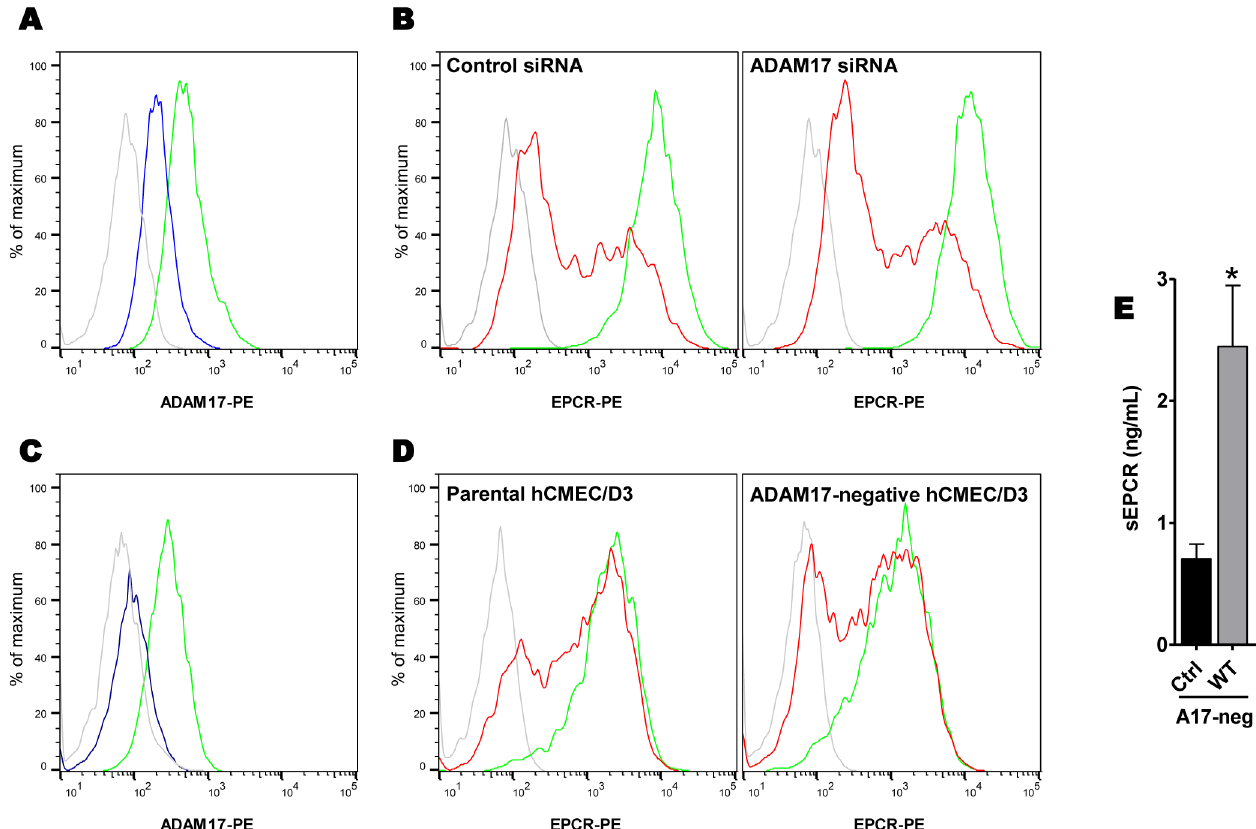
Fig 5. ADAM17 is not responsible for the meningococcus-induced EPCR shedding. (A) ADAM17 membranous expression of HDMEC cells transfected with a siRNA against ADAM17 (blue) or control (green). Grey: isotype control. For the quantification of ADAM17 expression see supplemental data S3 Fig. (B) EPCR expression in HDMEC cells transfected with either a control siRNA (left) or ADAM17 siRNA (right) and infected with a WT N . meningitidis strain for 4 hours (red) or left non-infected (green). Grey: isotype control. For the quantification of EPCR expression see supplemental data S3 Fig. A Crispr/ Cas9-mediated knockdown of ADAM17 expression was performed as described in Material and Methods in the Human Cerebral Microvessels Endothelial Cells line hCMEC/D3. (C) ADAM17 expression in the resulting cell line (blue) compared to that of the parental cell line (green). (D) EPCR expression in parental hCMEC/D3 cell line (left) or ADAM17-negative-hCMEC/D3 cell line (right) infected with a WT N . meningitidis strain for 4 hours (red) or left non- infected (green). The adhesion of N . meningitidis on hCMEC/D3 is reduced compared to the adhesion on HDMEC explaining the slighty reduced shedding phenotype observed with hCMEC/D3. Data are representative of 3 independent experiments. (grey: isotype control). For the quantification of EPCR expression see supplemental data S5 Fig. (E) Soluble EPCR in the supernatant of ADAM17-negative-hCMEC/D3 cells after infection with a WT strain or non- infected (control) cells. Data are mean (+/- SEM) of 3 independent experiments. (cid:3) : p = 0.007 (t-test).